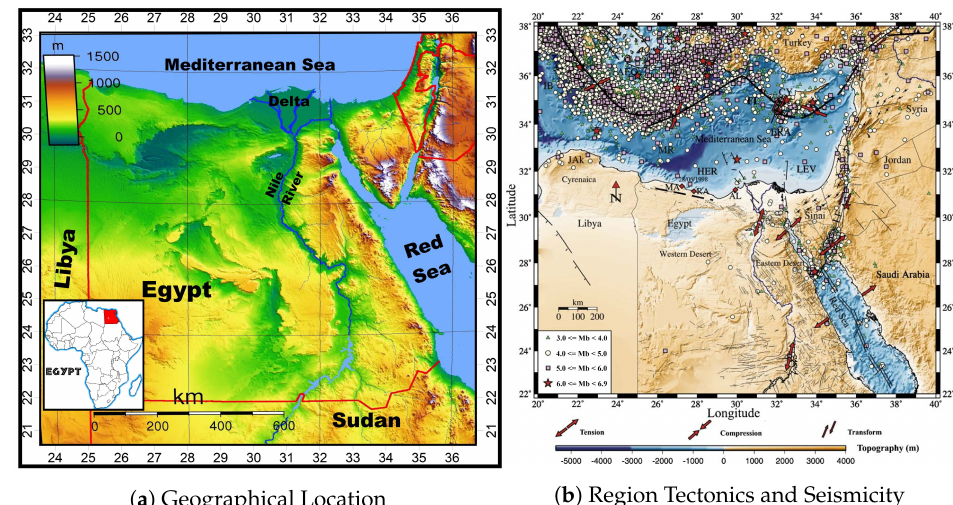
Figure 1. ( a ) Digital elevation model ( DEM ) of Egypt’s geographical location map and its correspond- ing distinct regions. ( b ) Tectonic boundaries of Egypt and the eastern Mediterranean region and shallow regional seismicity pattern (focal depth ≤ 60 km) [37]. Aegean Sea ( AEG ); Alexandria ( Al ) City; Cyprus ( CY ); Eratosthenes ( ERA ) Seamount; Florence ( FL ); Ionian Basin ( IB ); Mediterranean Ridge ( MR ); Levantine Basin ( LEV ); Levant Fault ( LF